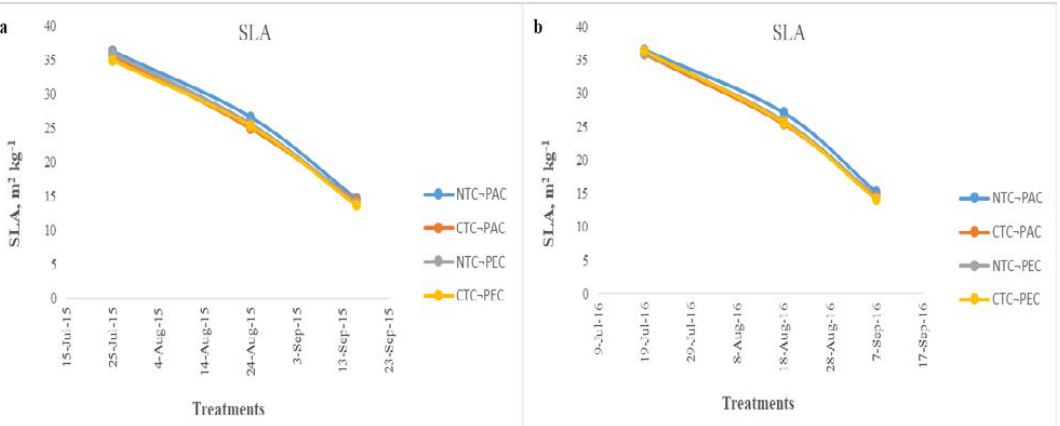
Figure 4. Specific leaf area (SLA) of the sunflower cultivation in two growing years of ( a ) 2015–2016 and ( b ) 2016–2017. NTC-PAC: no tillage planting parallel to the contour direction. CTC-PAC: conventional tillage planting parallel to the contour direction. NTC-PEC: no tillage planting perpendicular to the contour direction. CTC-PEC: conventional tillage planting perpendicular the contour direction.